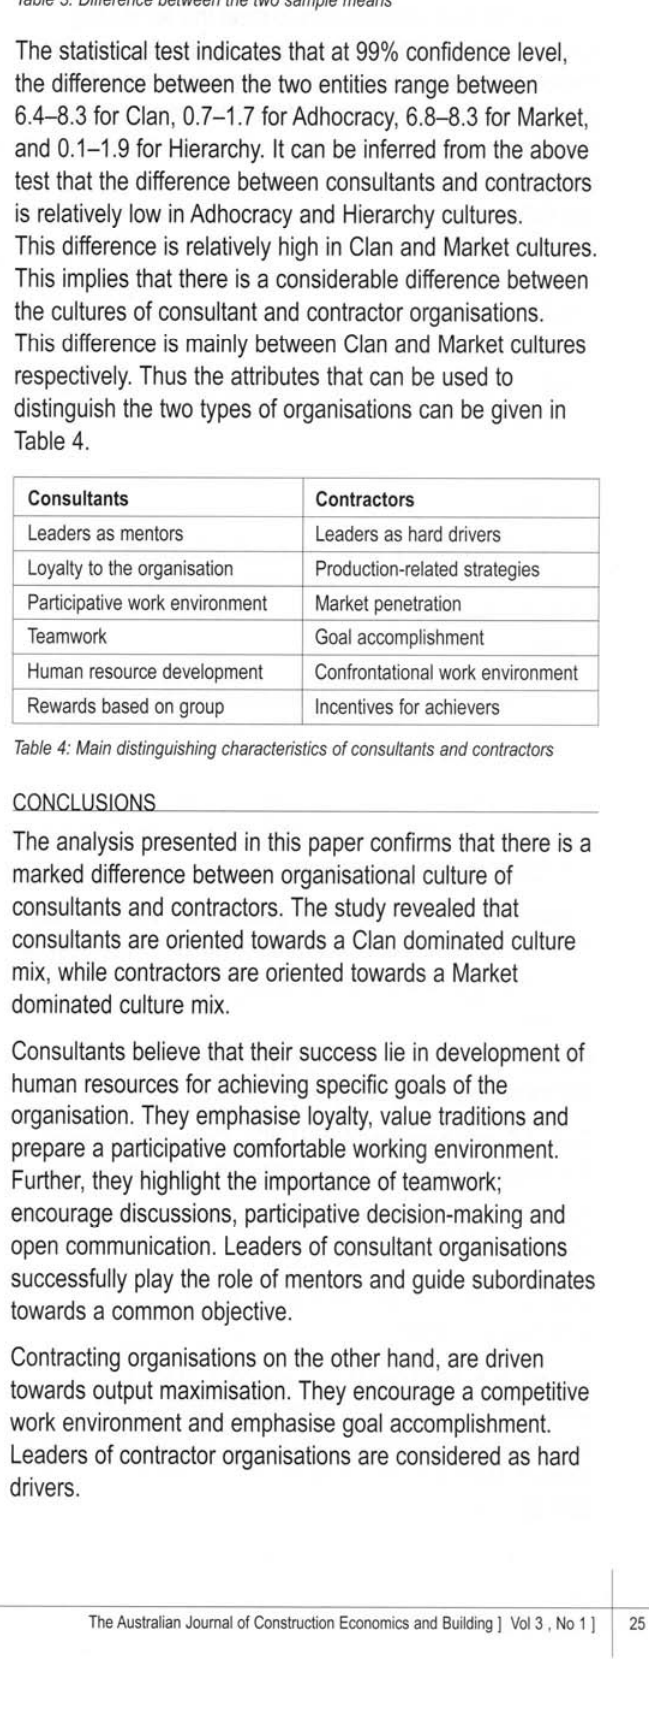
Table 3: Difference between the two sample means